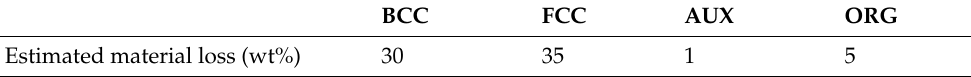
Table 9. Summary of estimated material lost as projected debris during compression tests.